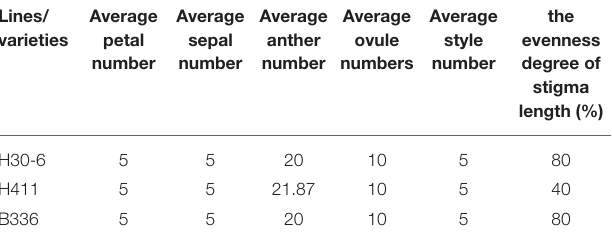
TABLE 2 | Flower organ numbers and evenness degree of stigma length of H30-6, H411, and B336. Lines/ Average varieties